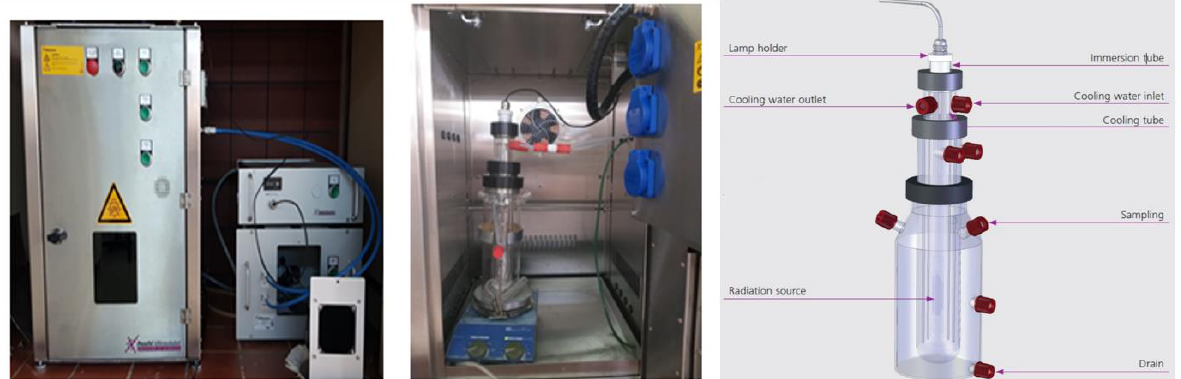
Figure 2. Photoreactor set up by Peschl Ultraviolet GmbH—Mainz, Germany; radiation protection cabinet; power supply and cooling unit ( left ); photoreactor vessel ( center ); vessel parts ( right ).